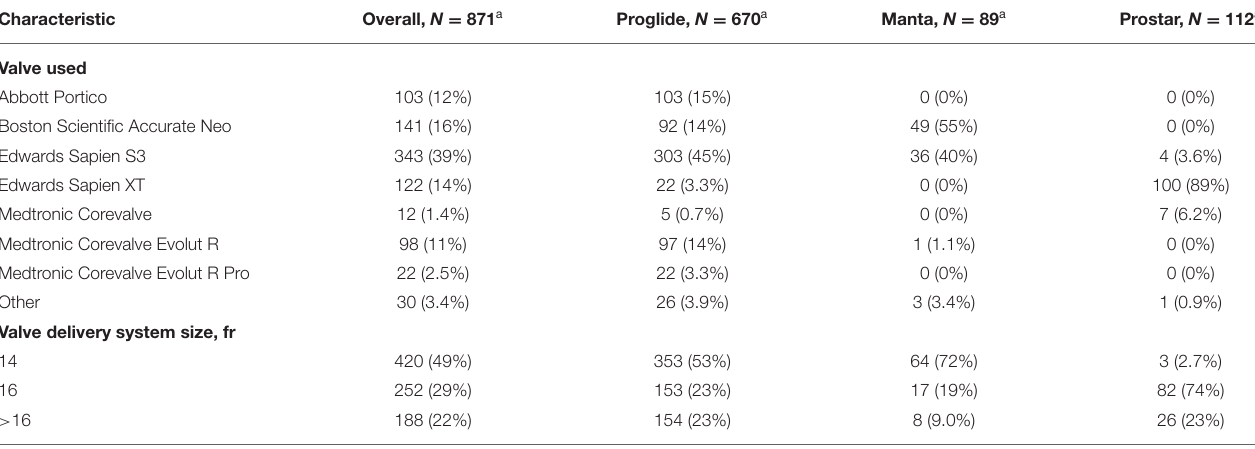
TABLE 2 | Baseline prosthesis characteristics according to vascular closure device used. Characteristic